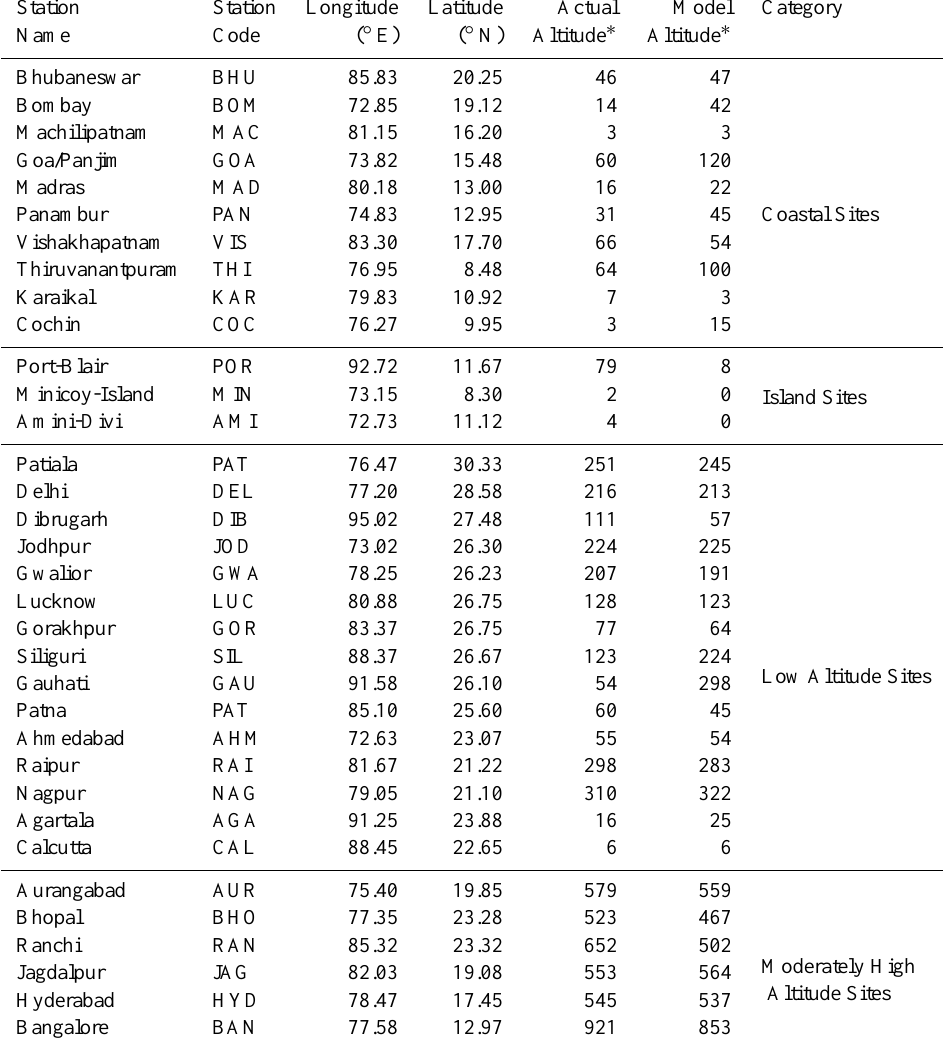
Table 1. Details and the categorization of the RAOB sites used in this study.